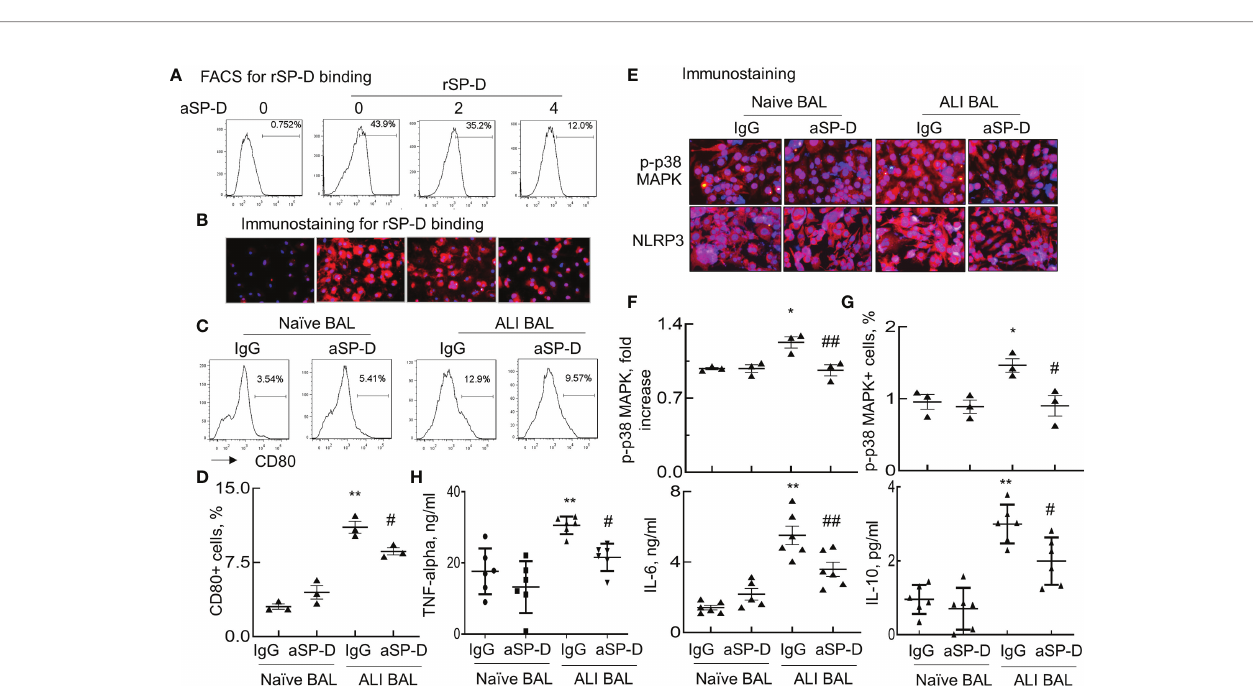
FIGURE 2 | Anti-surfactant protein D (aSP-D) reduced acute lung injury (ALI) mice-derived SP-D binding and activation of macrophages. RAW264.7 cells were treated with 2 µg/ml recombinant murine SP-D (rSP-D) (6×His) pre-neutralized with 2, 4 µg/ml aSP-D. The cells that were untreated (0 group) or treated with 2 µg/m rSP-D (6×His) preincubated with 2 µg/ml immunoglobulin G (IgG) (0/rSP-D group) were used as controls. (A) Flow cytometry analysis for rSP-D binding on treated RAW264.7 cells by Cy3-conjugated anti-His antibody. (B) Immunostaining for rSP-D binding to the treated cells (red). Representative photograph with magni fi cation ×200. (C) Flow cytometry analysis for macrophage activation induced by SP-D of bronchoalveolar lavage (BAL). RAW264.7 cells were treated with BAL of naive and ALI mice containing endogenous SP-D (naive BAL or ALI BAL) for 24 h. SP-D in BAL was pre-neutralized with 4 µg/ml aSP-D or IgG at 37°C for 1 h. Representative histogram for CD80 expression in the treated cells. (D) Quantitative analysis for CD80 expression in the treated cells. (E) Immunostaining for p-p38 mitogen-activated protein kinase (MAPK) and Nucleotide-binding oligomerization domain, Leucine rich Repeat and Pyrin domain containing Proteins (NLRP)3 expression in the treated cells. Red presents positively stained cells. Nuclei are stained with blue 4 ′ ,6-diamidino-2-phenylindole (DAPI). Representative photograph with magni fi cation ×200. (F) Quantitative analysis of p-p38 MAPK fl uorescence intensity in the stained cells by ImageJ software. Data were presented as mean increases of fl uorescence intensity over IgG in naive BAL control. (G) Flow cytometry analysis of p-p38 MAPK in the treated cells. Data were presented as mean percentage of positively stained cells. (H) ELISA analysis for the expression of tumor necrosis factor (TNF)-alpha, interleukin (IL)-6, and IL-10 in the supernatants of the treated cells. *p < 0.05, **p < 0.01 vs . IgG/naive BAL group; # p < 0.05, ## p < 0.01 vs . IgG/ALI BAL group for all quantitative